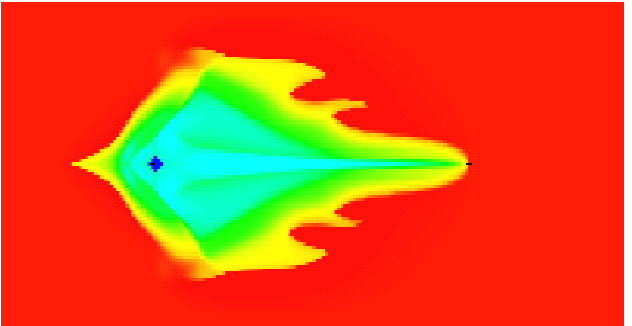
Figure 6. Distribution of formation oil saturation at 130 days of production.